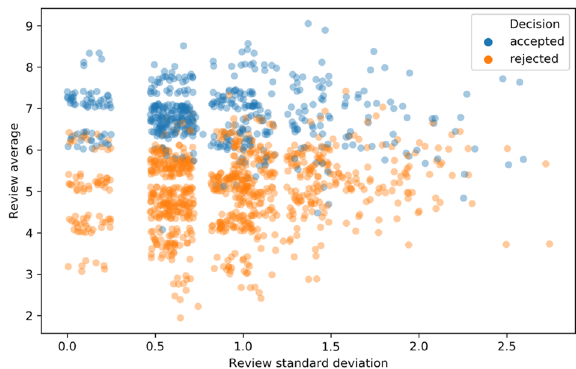
Fig. 4 Review standard deviation vs. review average for OpenReview datasets. Scatterplot of average vs. standard deviation of accepted and rejected OpenReview papers, with added jitter to improve